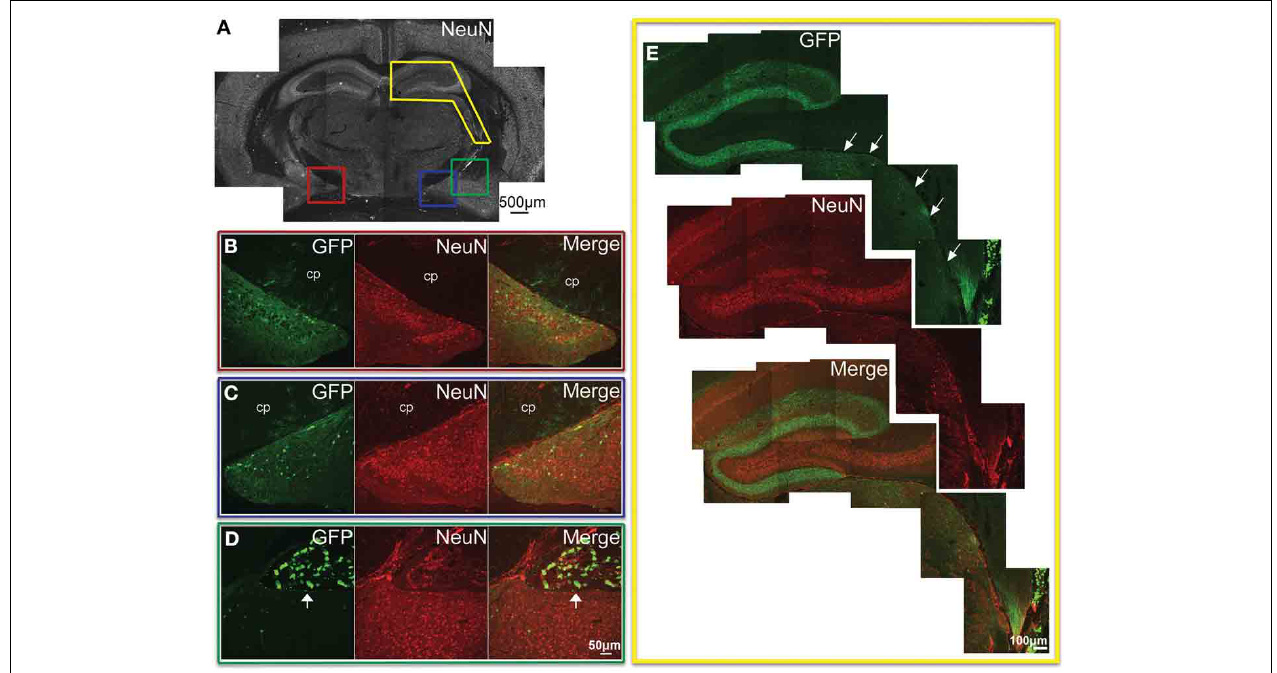
FIGURE 6 | GFP-ir in the hippocampal formation, amygdala, and thalamus. (A) Low magnification image of NeuN-ir and colored inset boxes illustrate the locations of images in (B–D) (approximately − 1.9mm Bregma). (B) Substantial GFP-ir in neurons of the ventral dentate gyrus, ventral hippocampus, and superior to those, astrocytes in the cerebral peduncle (cp). (C) GFP expression in the amygdalohippocampal area, and superior to that, astrocytes in the cerebral peduncle (cp). (D) GFP-ir in